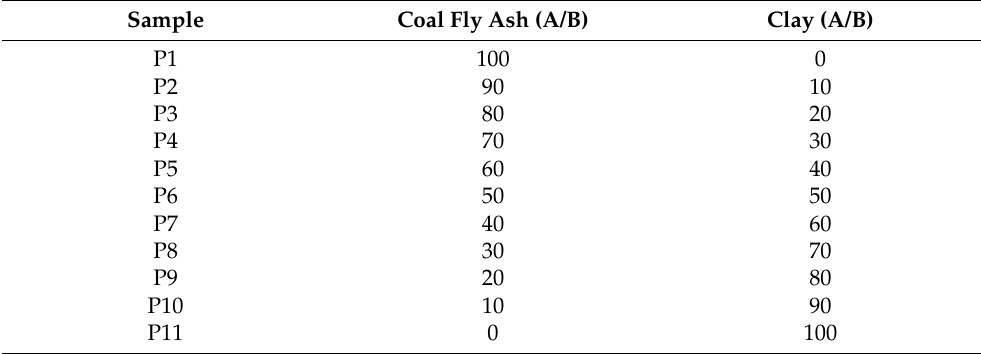
Table 1. Coal fly ash-clay brick